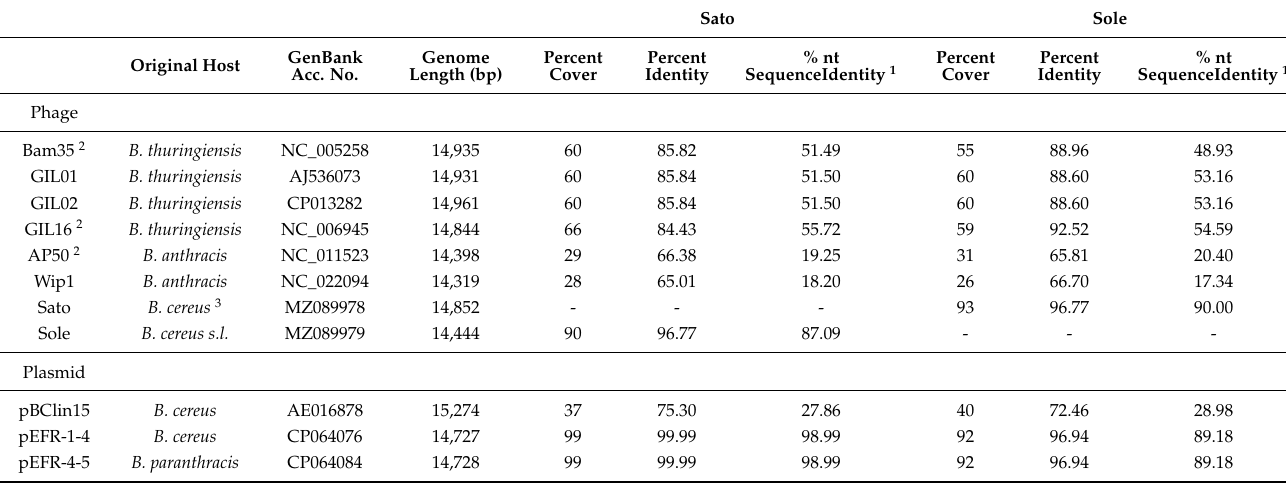
Table 3. Percentage of nucleotide sequence identities between tectiviruses Sato and Sole against fully sequenced phages belonging to the genus Betatectivirus and tectiviral-related